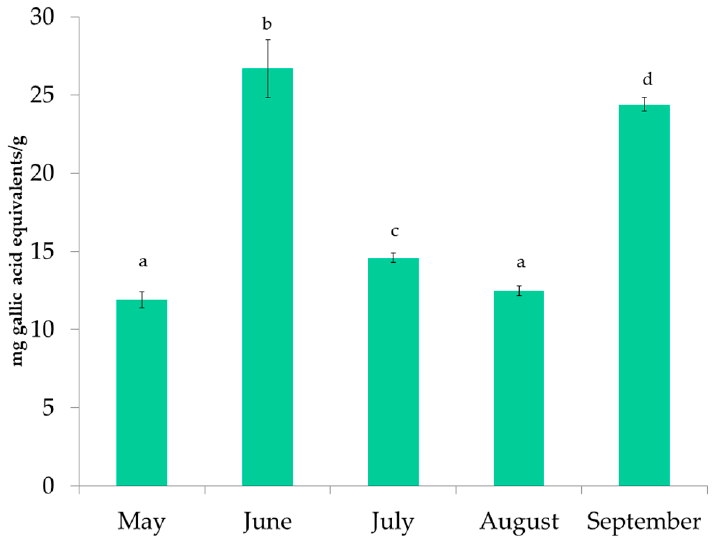
Figure 2. Total phenolic content of P. pavonica extracts. a–d different letters denote statistically sig- nificant difference.